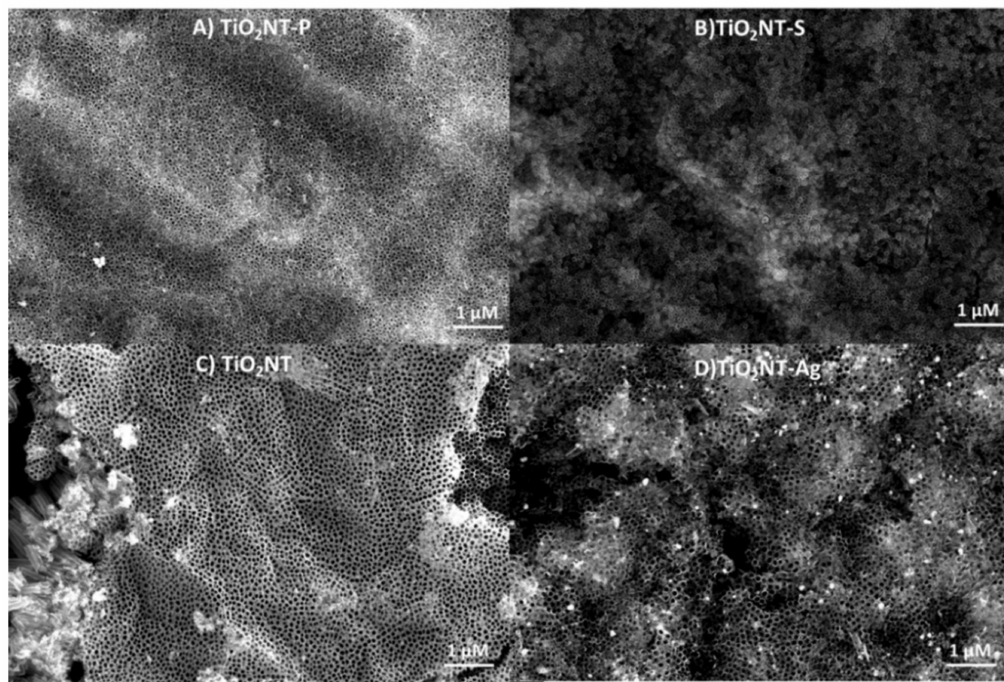
Figure 3. Surface view of the nanotubular morphology of the di ff erent photocatalysts: ( A ) TiO 2 NT-P, ( B ) TiO 2 NT-S, ( C ) TiO 2 NT and ( D ) TiO 2 NT-Ag.